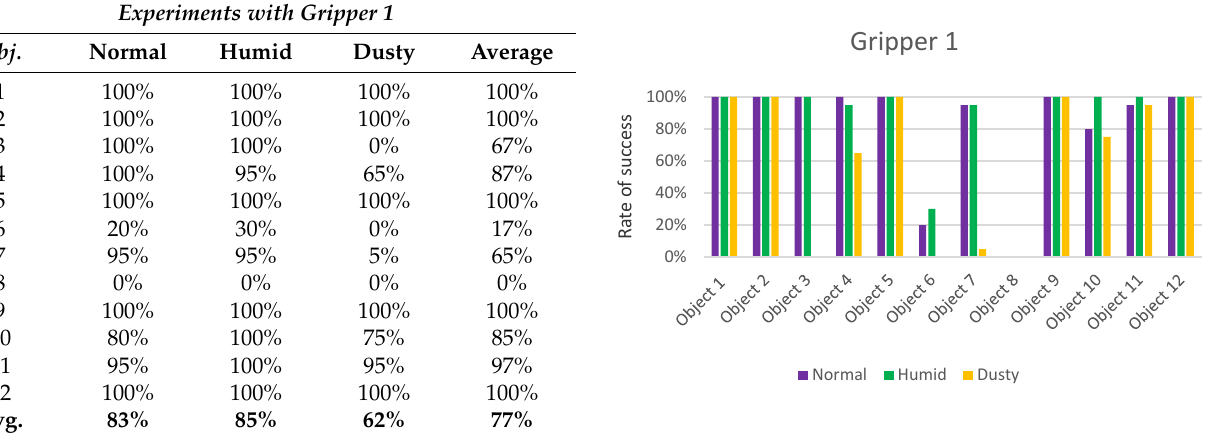
Table 2. Experiments with Gripper 1. On the left, the table with a success rate for every object, in the last column, the average for every object is calculated, and at the end of the table, the average success rate for every environment is determined. On the right, the graphic representation of Table 2 is reported.